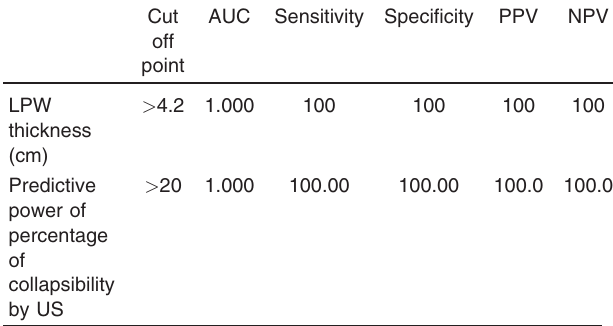
Table 8 Predictive power of different sonographic parameters among the nonintubated group Cut